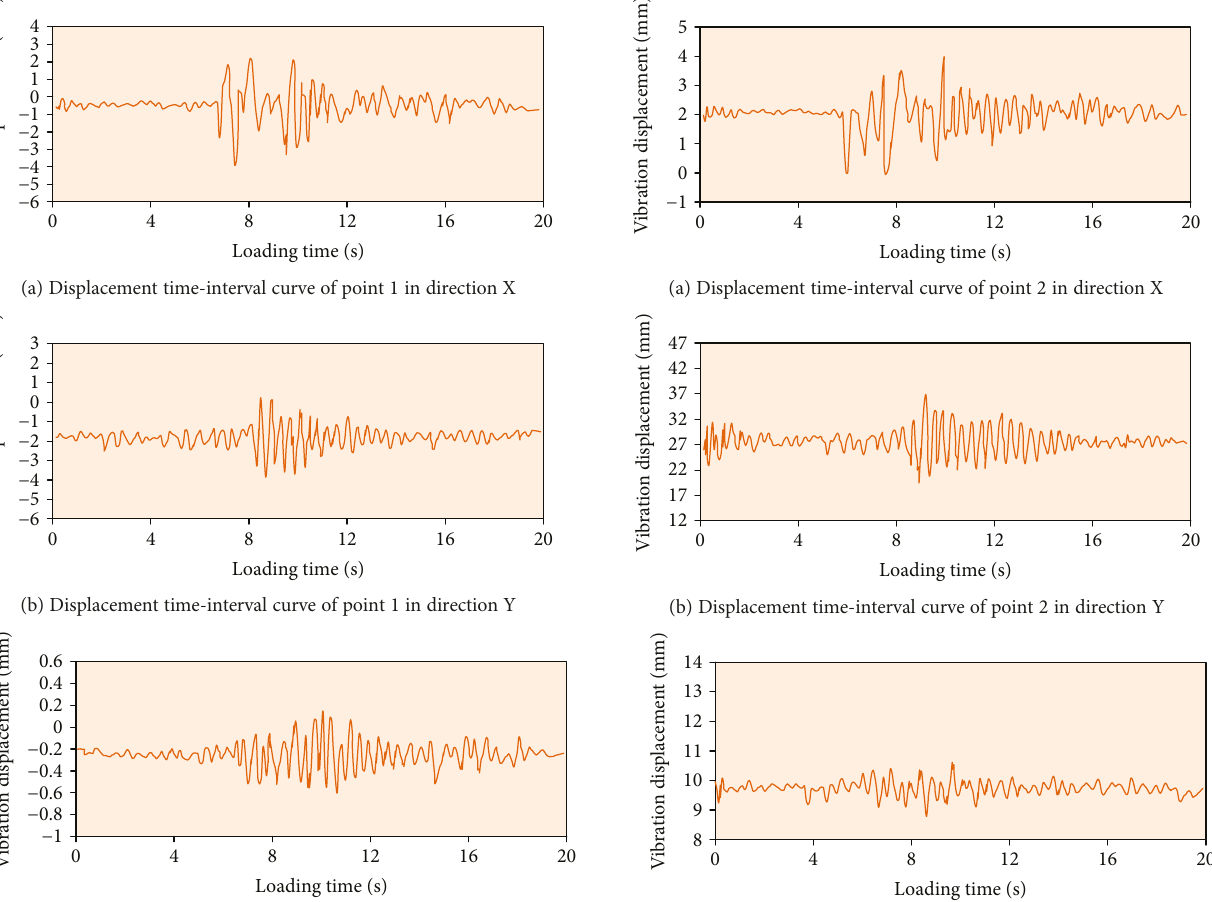
(c) Displacement time-interval curve of point 2 in direction Z Figure 22: Displacement time-interval curves of point 2 in directions X, Y, and Z.